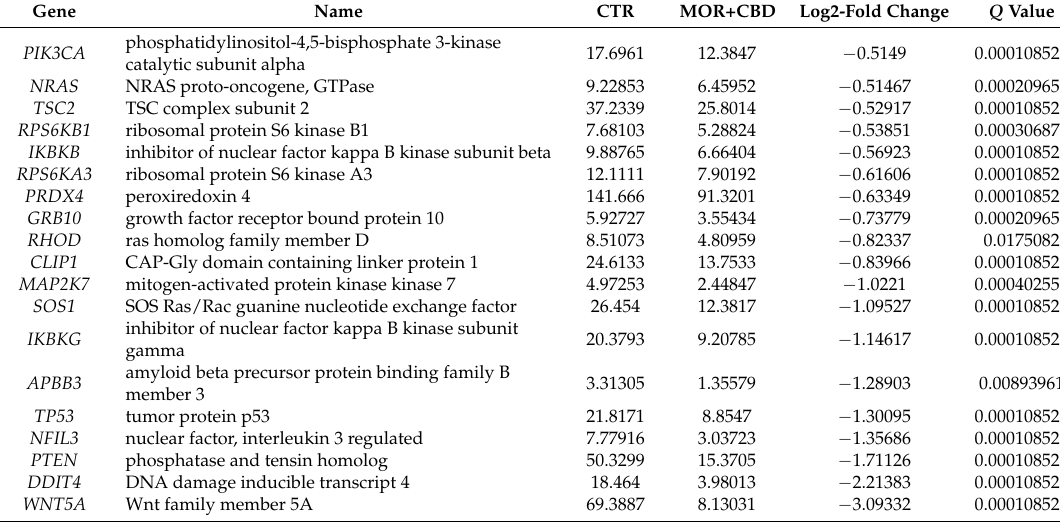
In table, we have reported: the nomenclature, the whole name, the gene expression value (FPKM) in untreated (CTR) and treated cells (MOR+CBD), Log2-fold change values, and q values (FDR) < 0.05. Table 6. Up- and downregulated genes, involved in “PI3K/Akt/mTOR